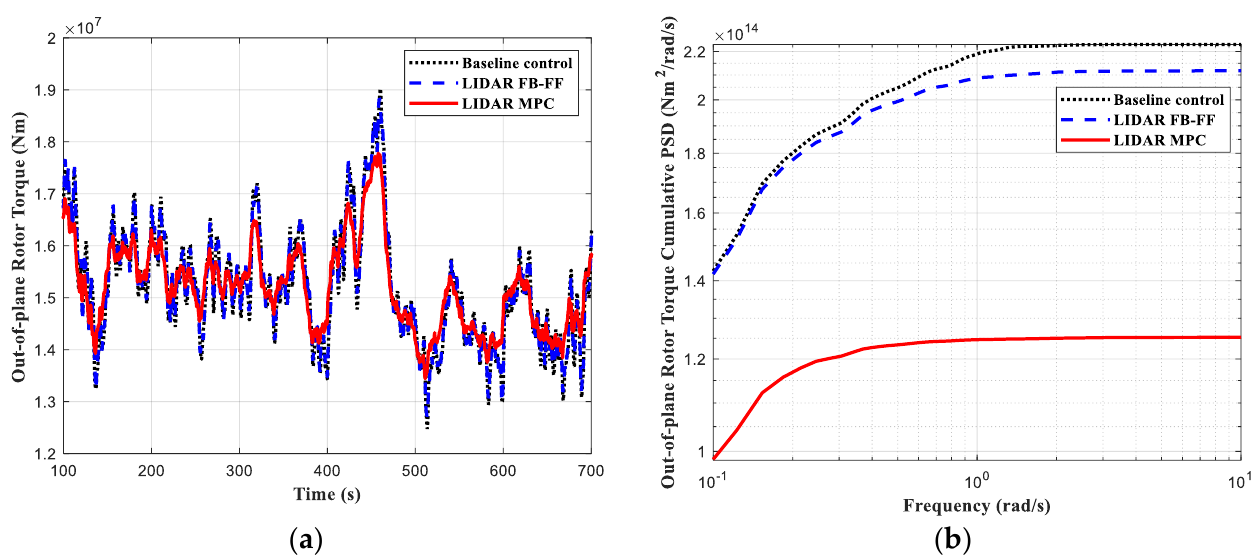
Figure 8. Out-of-plane rotor torque: ( a ) time profiles; ( b ) cumulative PSD (for wind speed with 10% turbulence intensity).